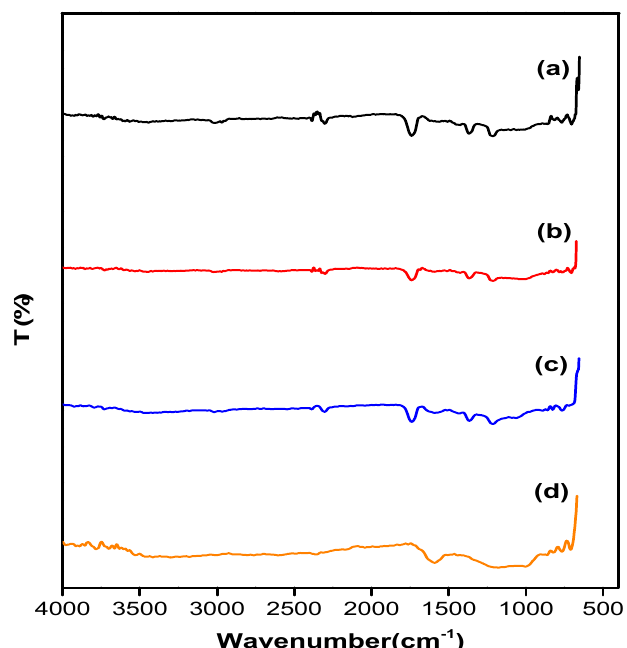
Figure 1. Fourier transform infrared spectroscopy of ( a ) AC-600 2:3; ( b ) AC-600 1:4; ( c ) AC-500 2:3 and ( d ) AC-500 1:4.